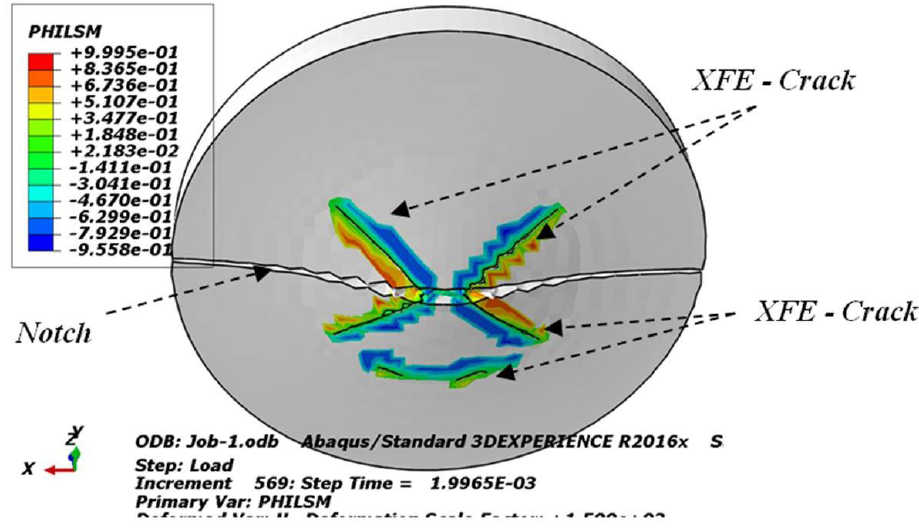
Figure 20. Site of crack initiation and crack path of SBN specimen with a/t =